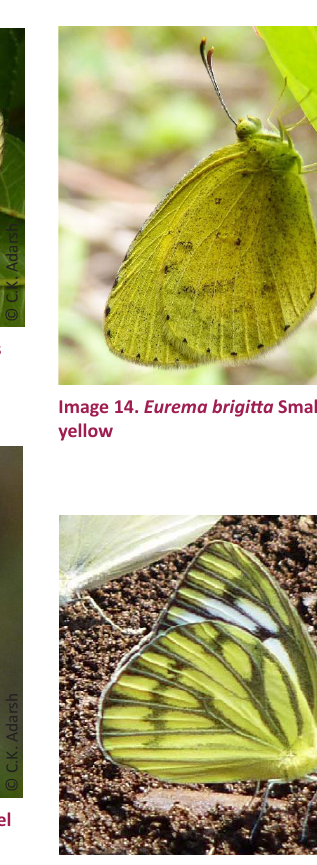
Image 17. Cepora nerissa Common